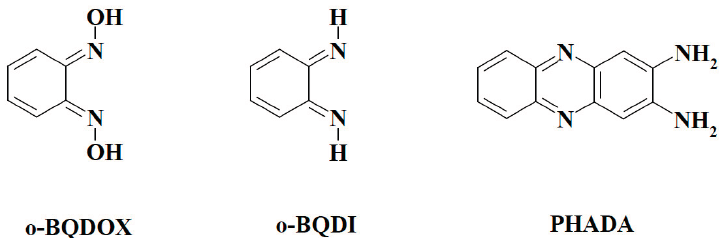
Figure 9. Structural formulas of the proposed reductive intermediates and the final product of benzofuroxan: o -benzoquinone dioxime ( o -BQDOX), o -benzoquinone diimine ( o -BQDI), and 2,3-diaminophenazine